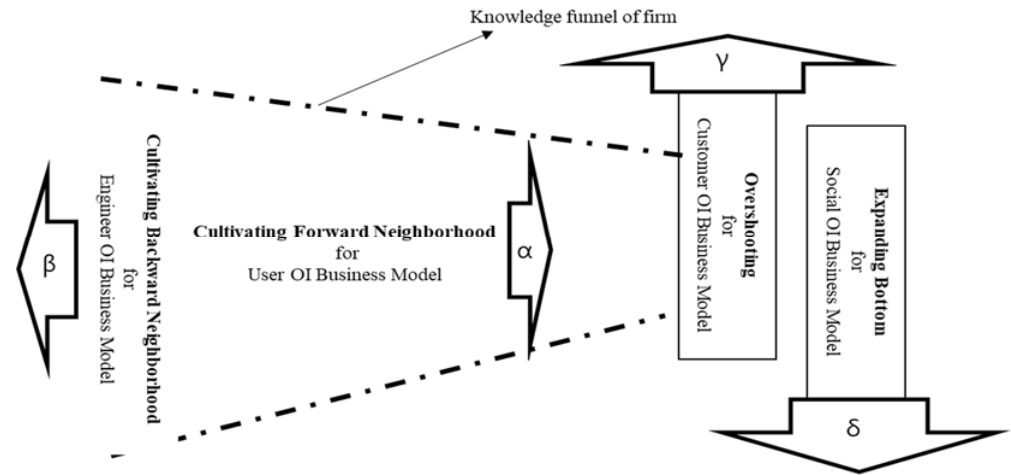
Figure 2. Research Framework II: rectangular compass in the knowledge funnel.